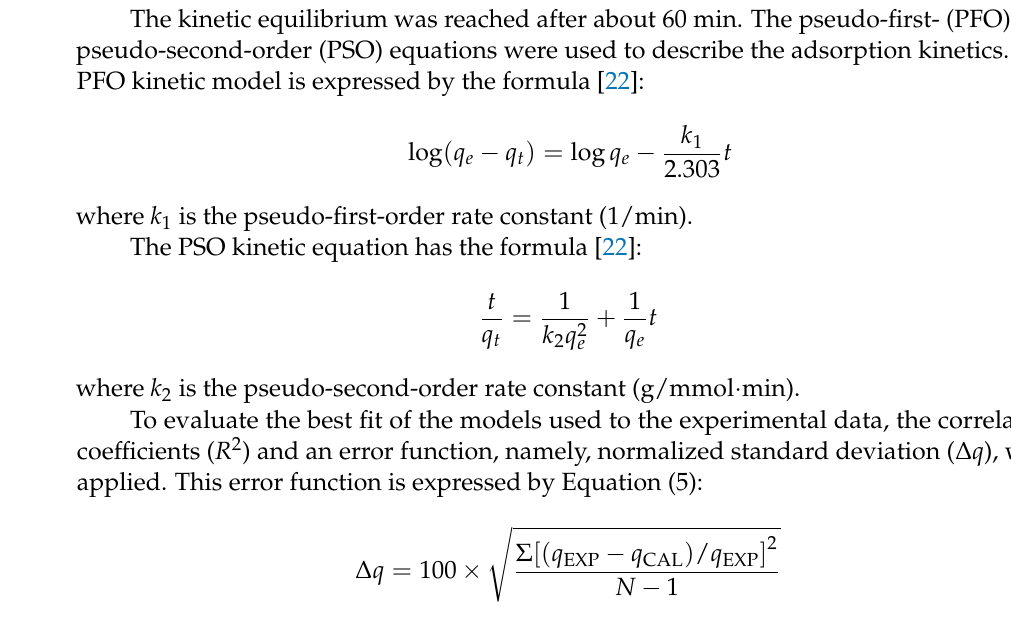
Figure 6. Adsorption kinetics of 2,4-D and MCPA on carbon black samples (line: fitting of PSO kinetic model).